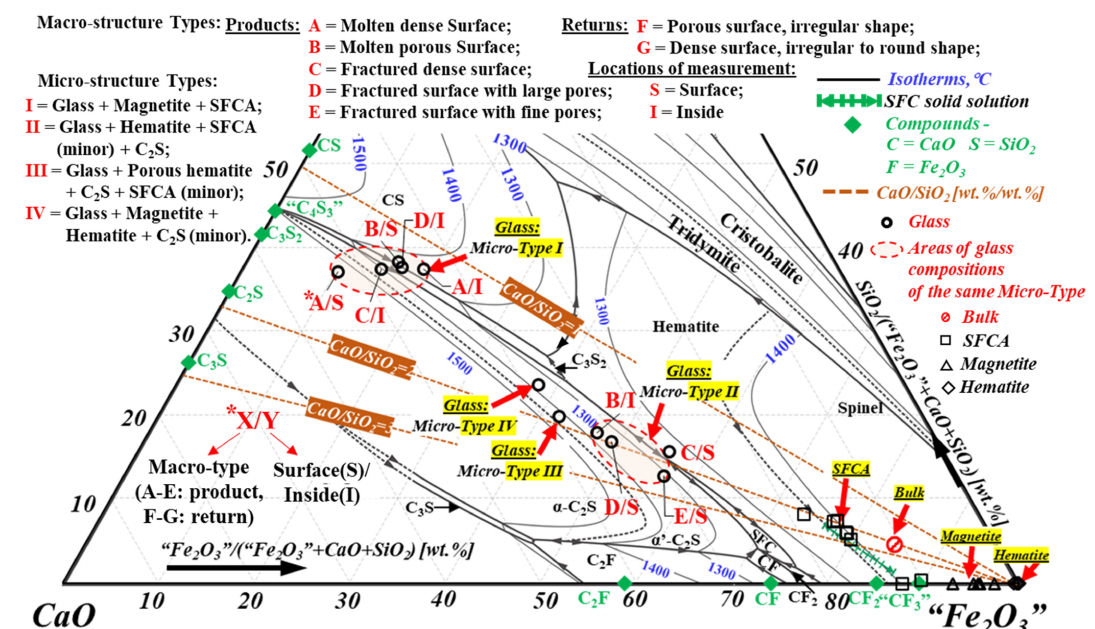
Figure 12. Compositions of phases in Microstructure-Types I–IV measured by EPMA projected onto the “Fe 2 O 3 ”-CaO-SiO 2 system in air based on the study by Cheng et al. [20], compositions in wt%, temperature in ◦ C, *X denotes sample Macro-Types, Y denotes locations of measurement taken.